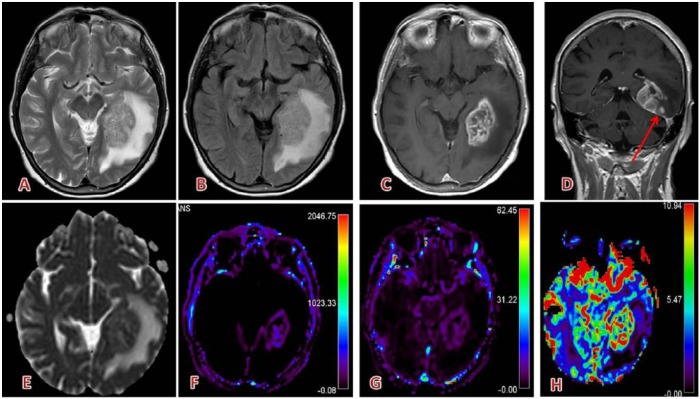
Typical glioblastoma (WHO grade IV): (A) left temporal big lesion, inhomogeneous and slightly hyperintense on T2 and (B) fluid-attenuated inversion recovery, with high, irregular enhancement after gadolinium-based contrast agent injection (gadobutrol: 5 + 5mL according to perfusion protocol in (C) and (D)), necrotic components, and restricted diffusion (apparent diffusion coefficient map, E); surrounding edema (A, B, E), small satellite lesion (arrow in D); high DSC and DCE perfusion parameters (Ktrans: F, Vp: G, rCBV: H).